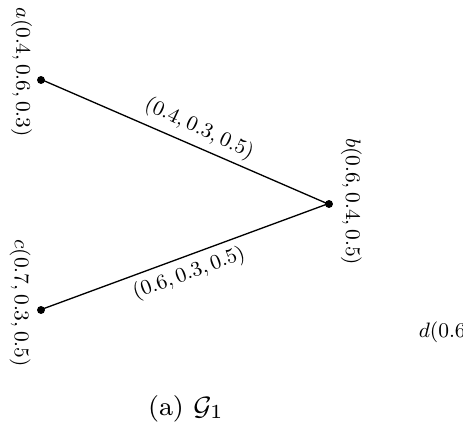
Figure 2. Spherical fuzzy graphs